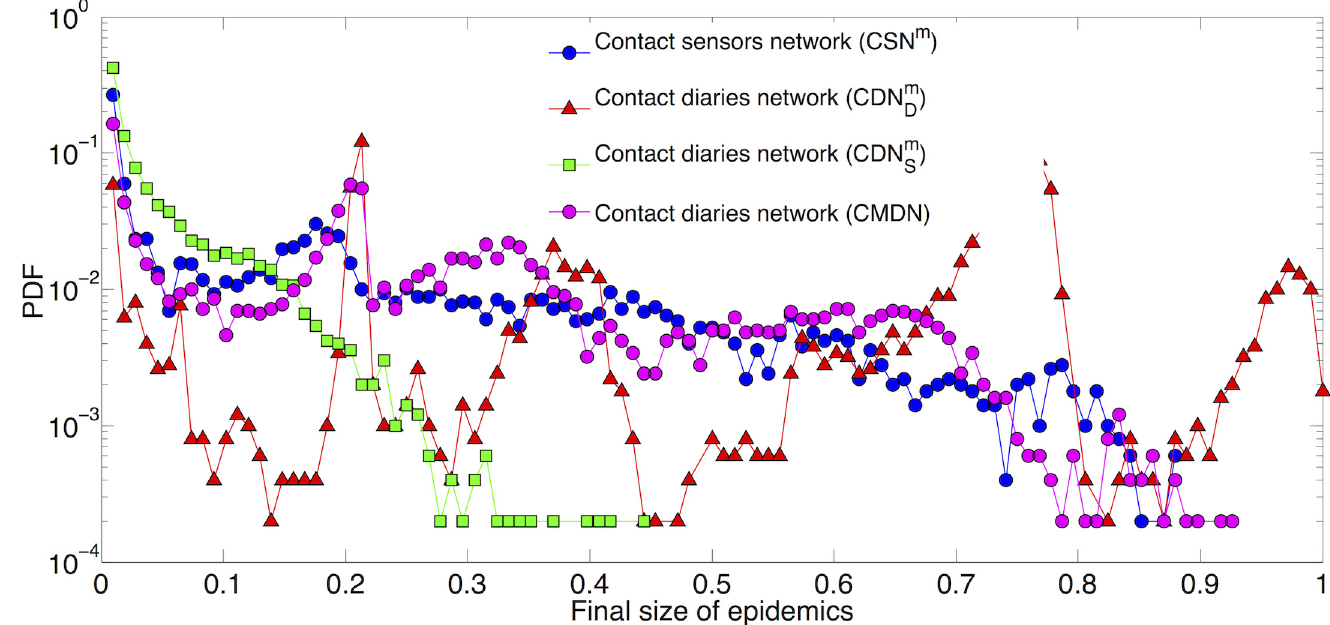
Fig 2. Distribution of final size of epidemics. 1000 SIR simulations performed on the matched contact sensors network (CSN m ), the matched contact diaries network with durations respectively reported by students (CDN m obtained by a negative binomial fi t of contact durations reported by students between and within classes (CMDN). Each process starts with one random infected seed. β / μ =